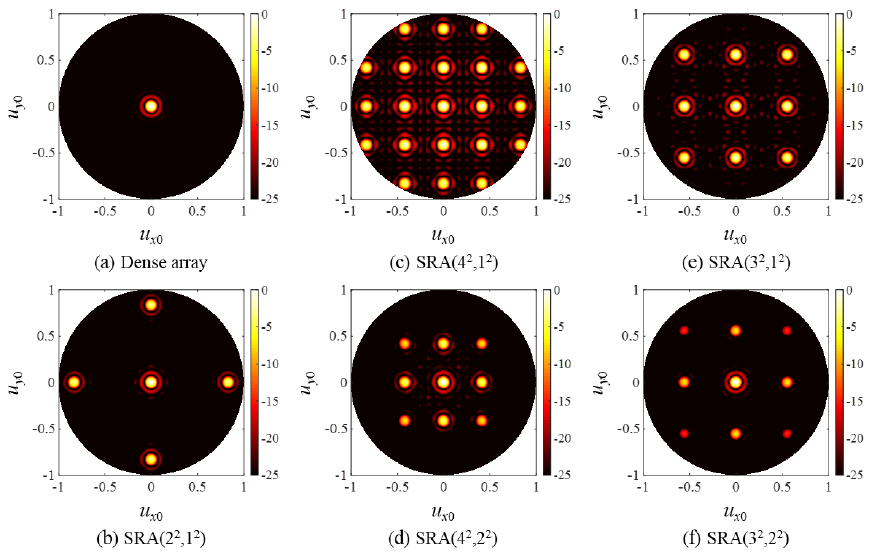
Figure 6. One-way, continuous wave (CW) responses of ( a ) the dense array and ( b – f ) the